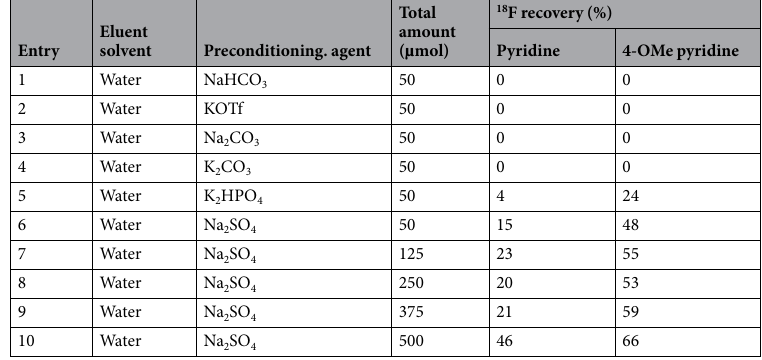
Table 3. Effect of pre-conditioning agent on the elution of [ 18 F]fluoride with aqueous pyridine and 4-OMe- pyridine.